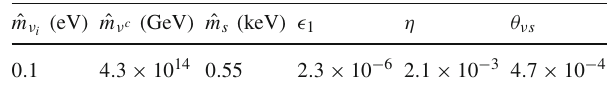
= 174 GeV, Table 6 Masses computed for the following scales: m ν D M ν c = 4 . 3 × 10 14 GeV, M s = 19 . 1 keV, M ν c s = 89 . 3 × 10 3 GeV, (cid:22) m 2 = 2 . 2 × 10 − 3 eV 2 , and the first and second generation of heavy (cid:2) (cid:3) 31 neutrinos at 1 . 8 × 10 10 , 3 × 10 10 GeV. Regarding the neutrinoless → 0 . 6 double beta decay, the model probes the blue region of ˆ m 1 ˆ m 2